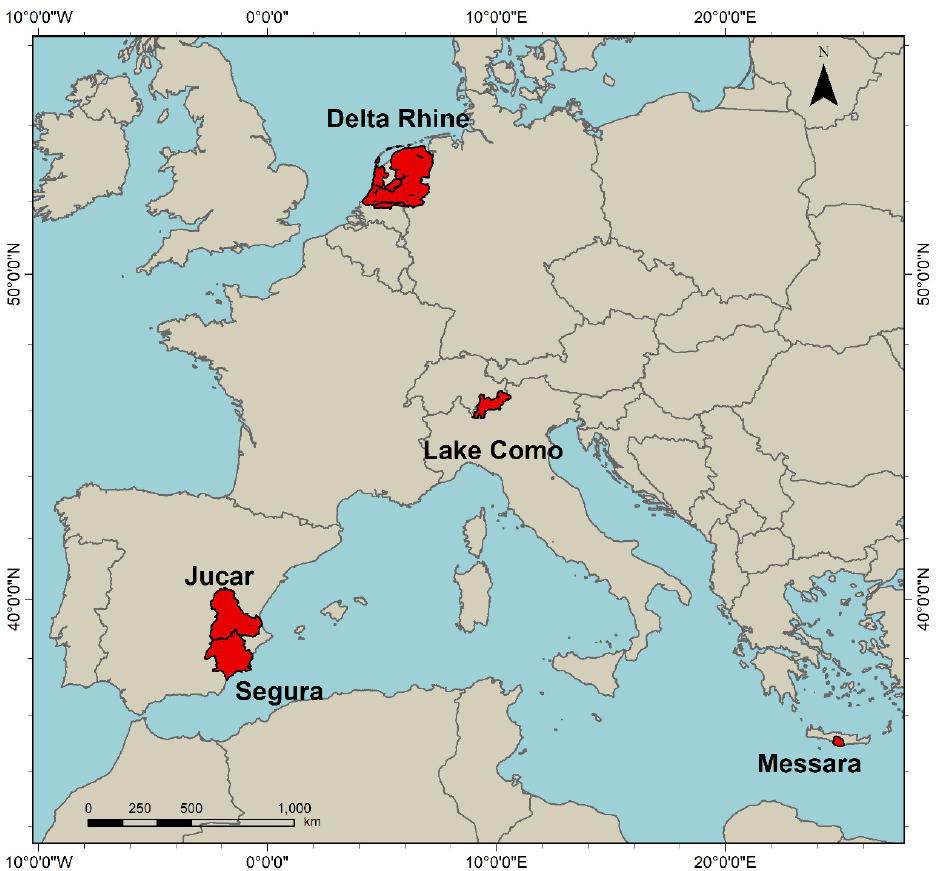
Figure 1. Location of the five river basins case study areas.